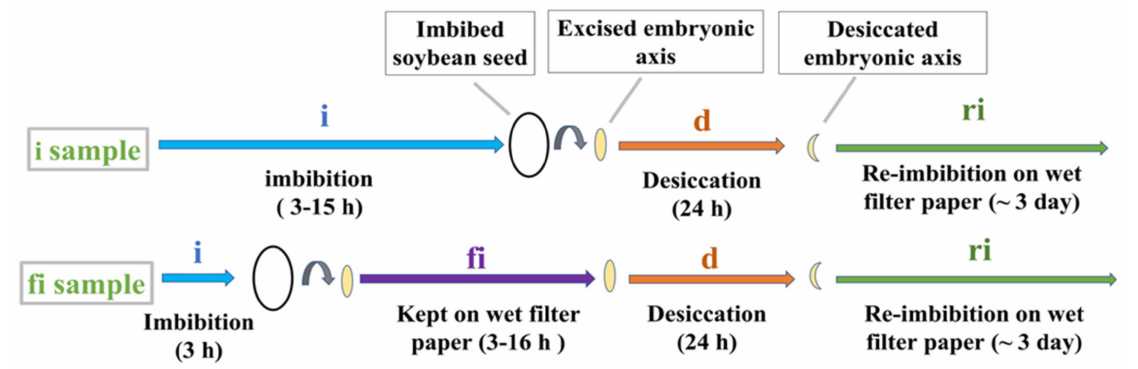
Figure 1. Experimental scheme for sample preparation. Second row: excised embryonic axes from imbibed ( i ) seeds were further imbibed on wet filter paper ( fi ) before desiccation ( d ) and re-imbibition ( ri